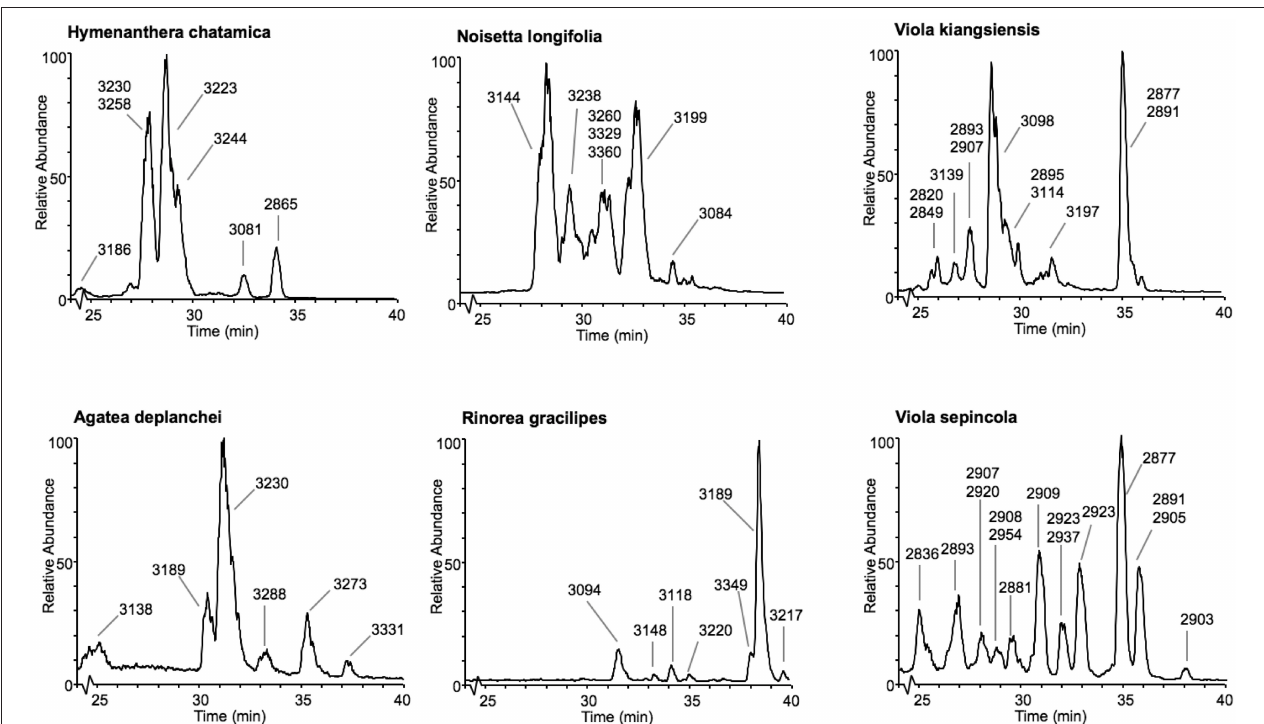
FIGURE 3 | Base peak chromatograms (m/z = 800–1900) from six representative species in the Violaceae. The cyclotide region spanning from 25 to 40min is shown, and major components are labeled with molecular weights (Da). Note that the LC-MS traces of Viola kiangsiensis and Viola sepincola contain more cyclotides, and also express varv A (mass 2877 eluting at 35min), which is found in 2/3 of all Viola species.